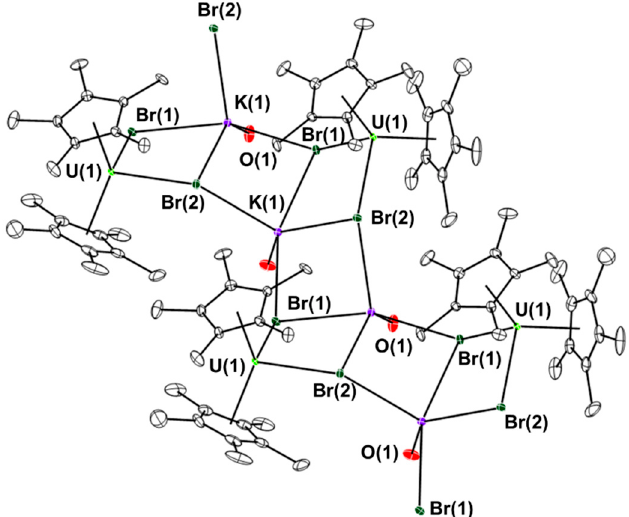
Figure 4. Solid state structure (30% probability ellipsoids) of a tetrameric unit of [K(THF)][(C 5 Me 5 ) 2 UBr 2 ] ( 41 ) Hydrogen atoms and the carbon atoms of THF molecules are omitted for clarity. Selected bond distances (Å) and bond angles (°): U(1)–Br(1), 2.9126(6); U(1)–Br(2), 2.8953(6); K(1)–Br(1), 3.1681(14), 3.2577(15); K(1)–Br(2), 3.1671(14), 3.2477(15); K(1)–O(1), 2.641(6); U(1)–C Cent(1) , 2.495(7); U(1)–C Cent(2) , 2.485(7); Br(1)–U(1)–Br(2), 88.841(19); Br(1)–K(1)–Br(2),